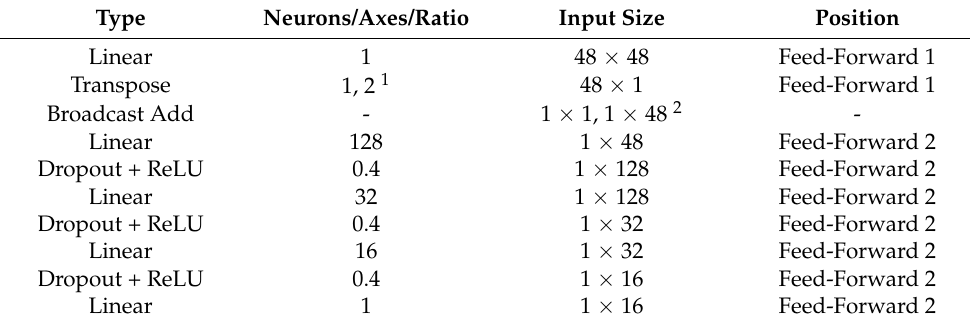
Table 2. Structure of the two feed-forward